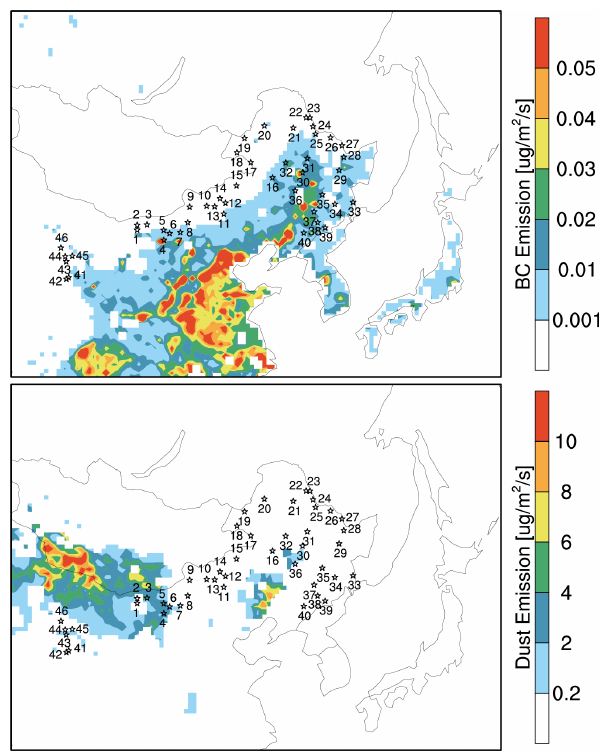
Figure 1. Model domain with BC and dust emissions in January– February 2010. The 46 observation sites in the North China cam- paign are denoted by pentagrams in